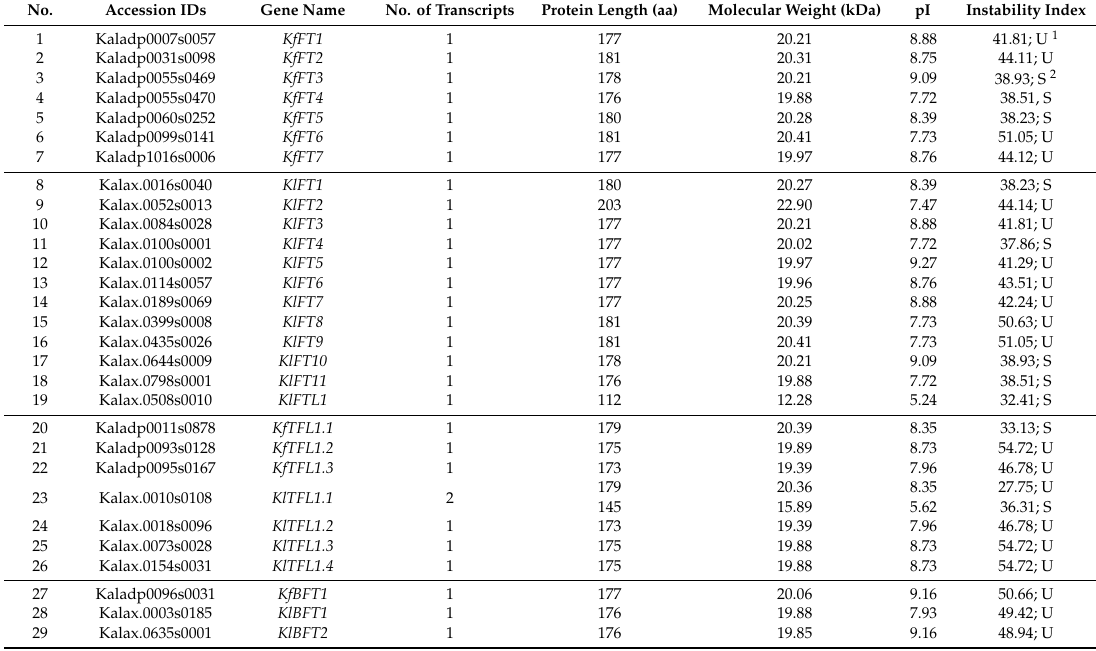
Table 1. Characterization of PEBP genes and proteins from